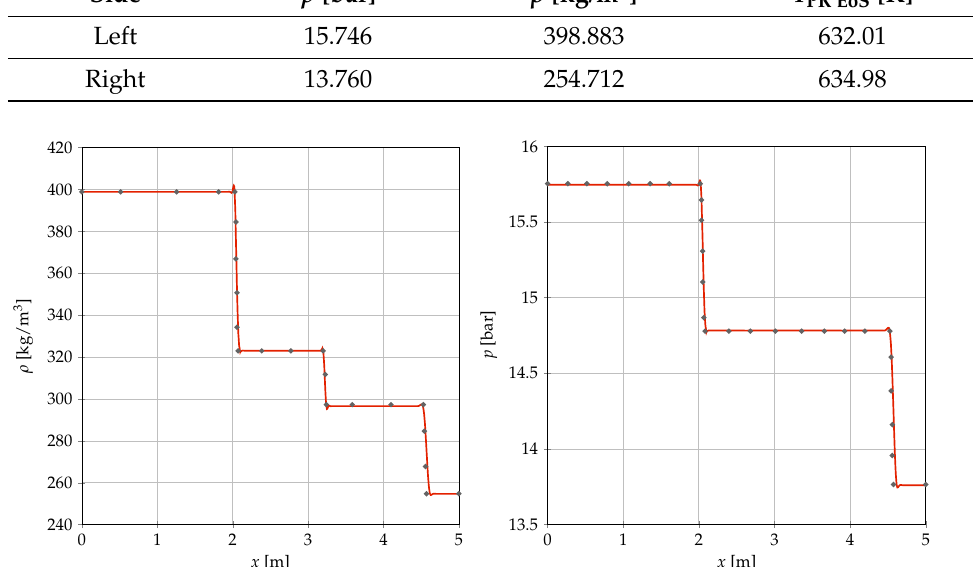
Figure 1. Shock tube. Density and pressure profiles at time t = 29.46 P 2 PR dG −